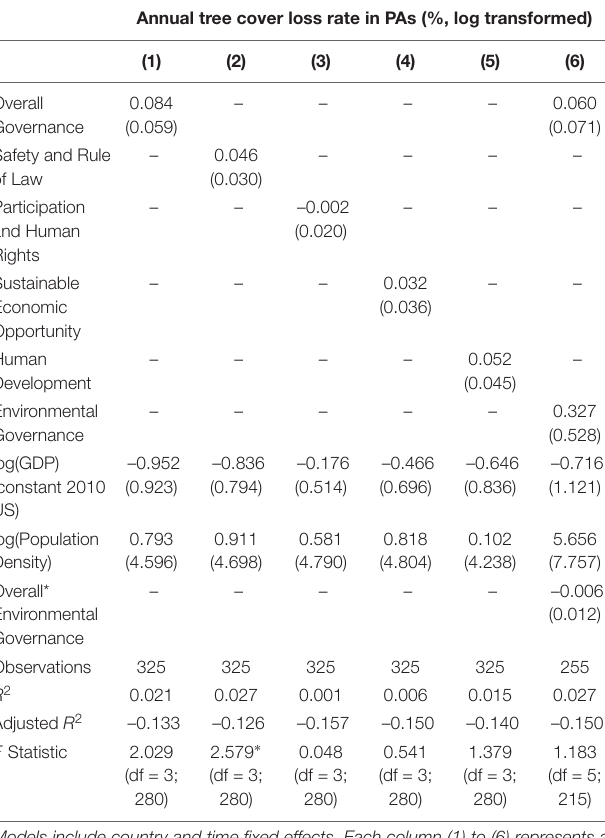
TABLE 2 | Summary of parameter estimates (clustered SE) from panel linear regression of tree cover loss against governance and additional covariates, considering changes within countries over